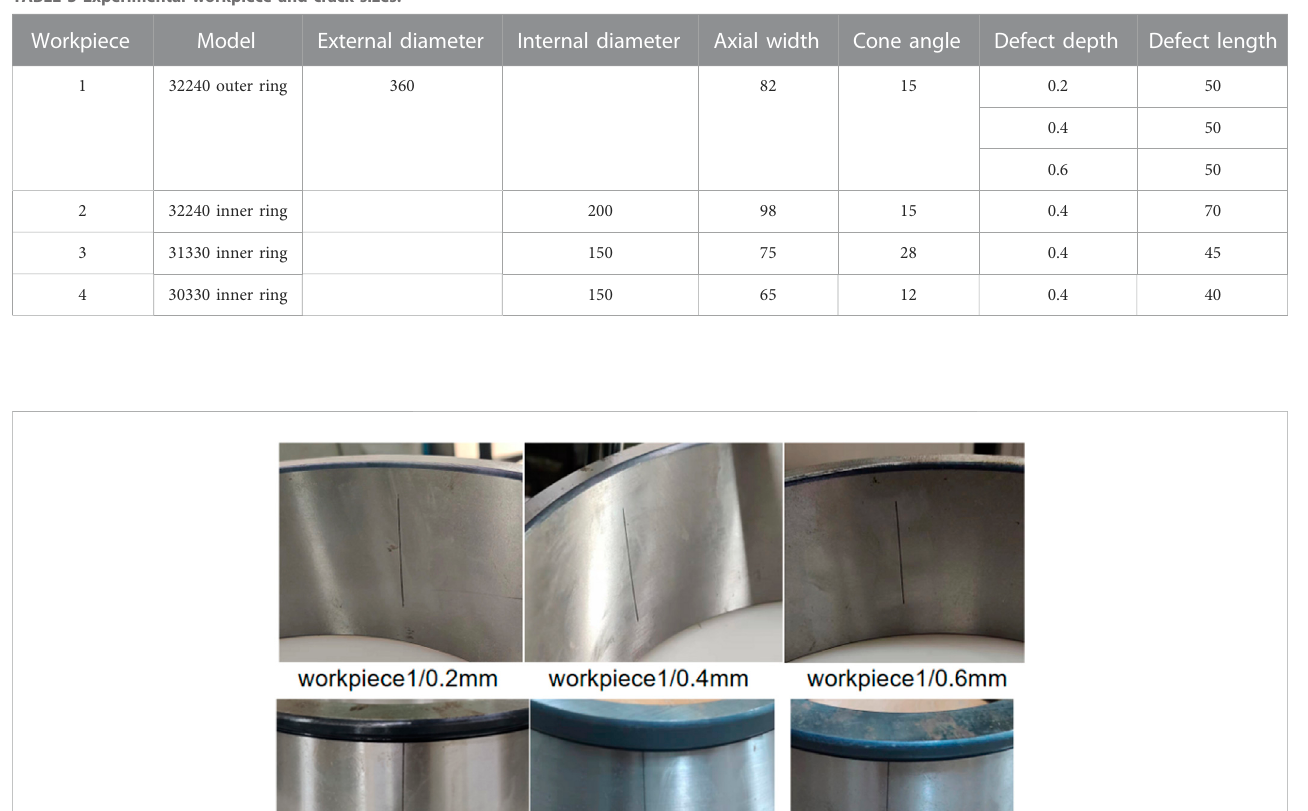
TABLE 3 Experimental workpiece and crack sizes.